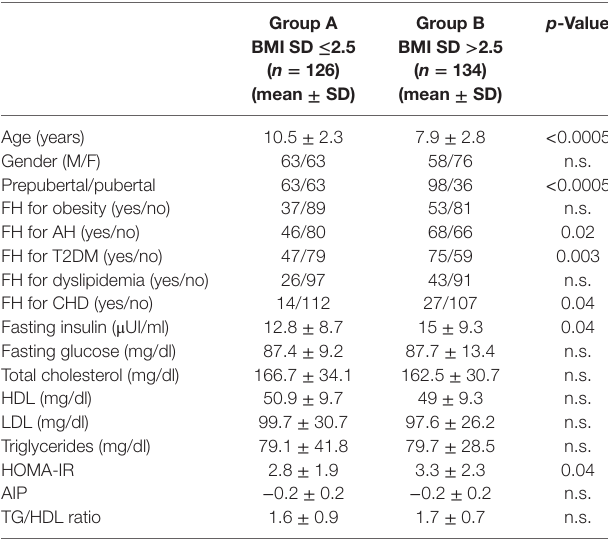
Table 2 | Family history, clinical, and biochemical data according to BMI SD ≤ 2.5 or >